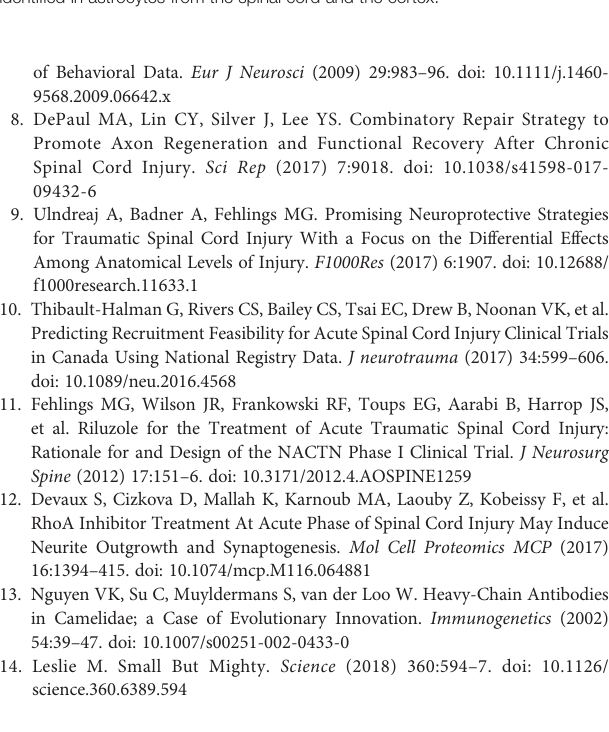
Supplementary Table 1 | Sequence read archive data from rat dorsal root ganglion explant and primary culture of DRG neurons revealed the expression of genes coding immunoglobulin heavy and light chains as well as cluster of differentiation markers. Supplementary Figure 1 | (A) IgG3 , (B) IgH-Vs107 , (C) Cd32b , and (D) CdD16 mRNA expression in the hippocampus and in the cerebellum of mice according to the Allen Brain Atlas, mRNA expression. Supplementary Figure 2 | (A) IgG3 mRNA expression in the spinal cord; (B) of mice according to the Allen Brain Atlas, mRNA expression. Supplementary Figure 3 | Heatmap illustrating hierarchical clustering obtained after analysis of digested peptides isolated from rostral, caudal, and lesion segments collected 12 h after lesion and treatment with RhoA inhibitor. Cluster 1 corresponds to the in fl ammatory proteins and immunoglobulins. Cluster 2 contains proteins involved in synaptogenesis, and Cluster 3 proteins are involved in neurite outgrowth. Supplementary Figure 4 | Rodent mRNA species after NGS sequencing showing the highest fold changes in EAE spinal astrocytes as compared to control spinal cord astrocytes IgHa , Ig Kappa c , J Chain , and Cd32b mRNA have been identi fi ed in astrocytes from the spinal cord and the